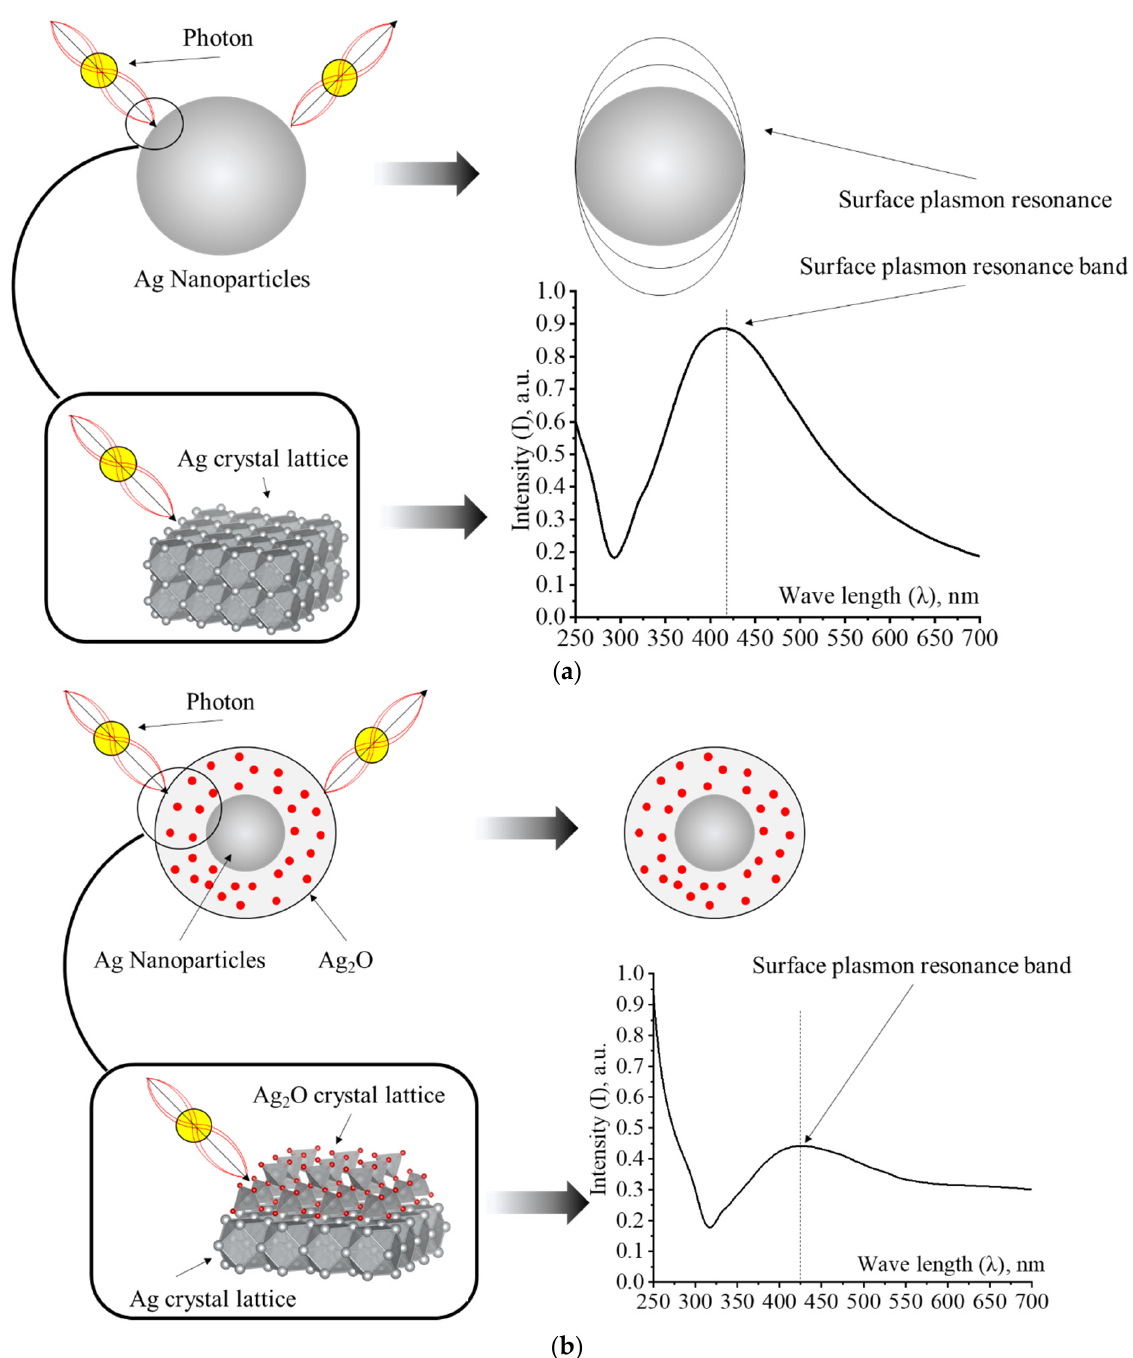
Figure 14. Diagram of changes in optical properties during oxidation of Ag NPs: ( a )—Ag NPs and ( b )—oxidation of Ag NPs surface.